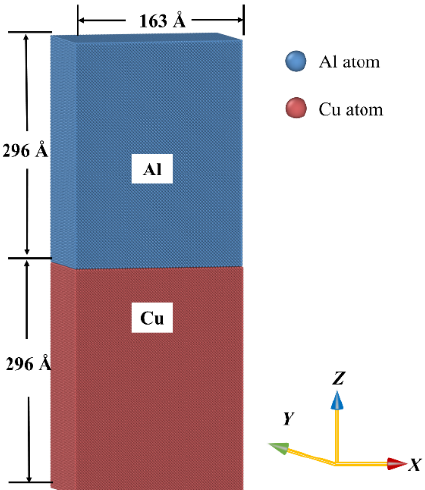
atoms at the bottom and the top along Z direction were fixed. Periodic boundary conditions were applied to the unit cell in other directions.